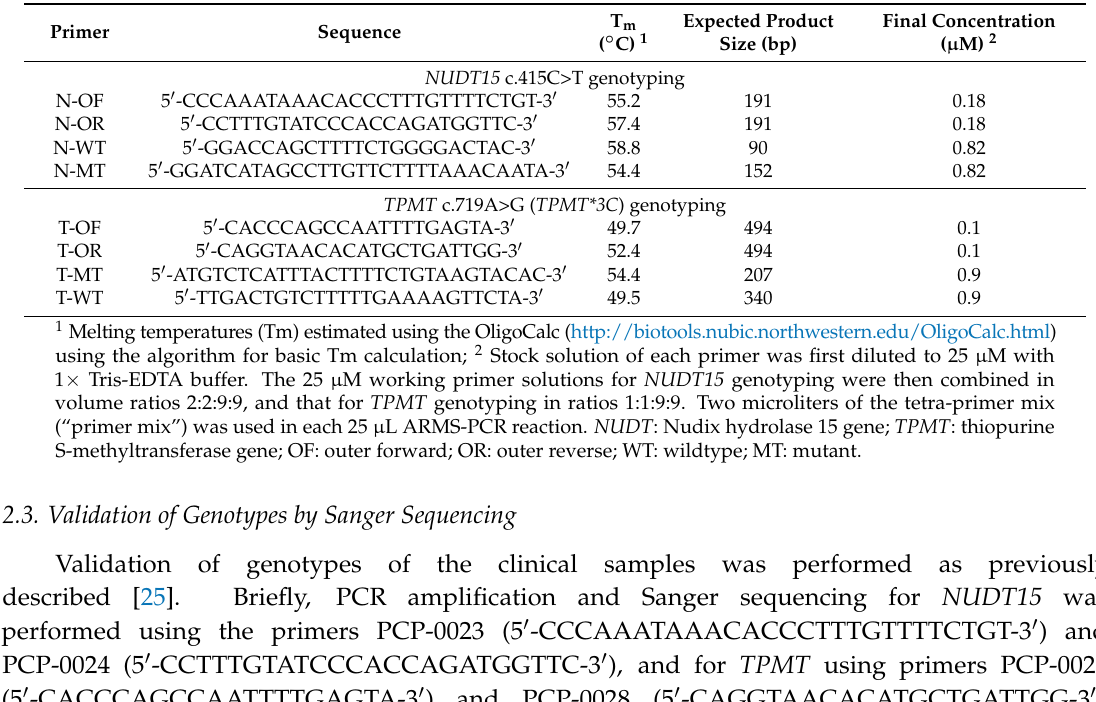
Table 1. Primers used for amplification refractory mutation system polymerase chain reaction (ARMS-PCR)